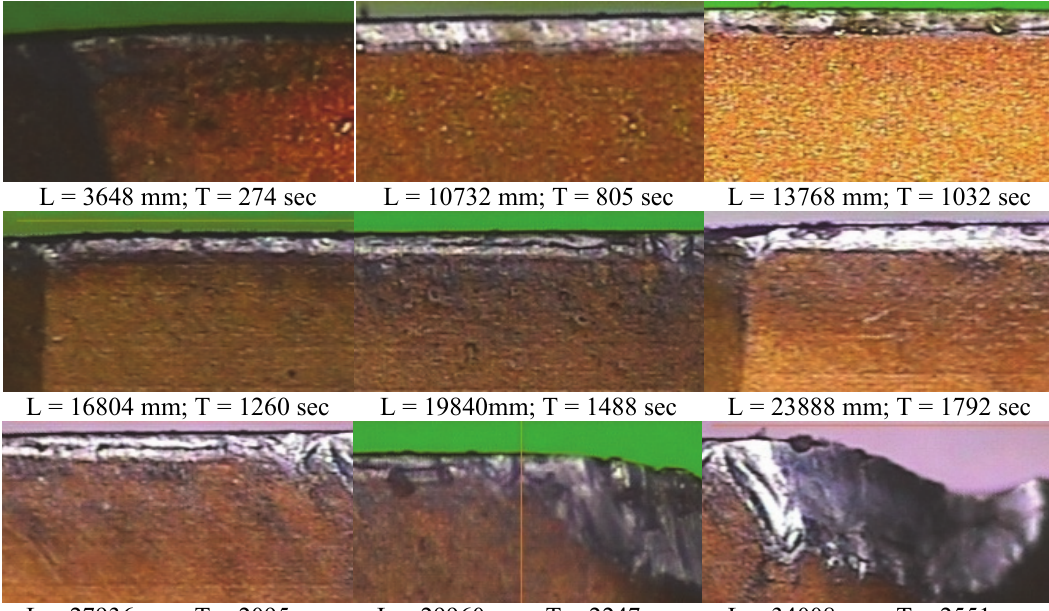
L = 3648 mm; T = 274 sec